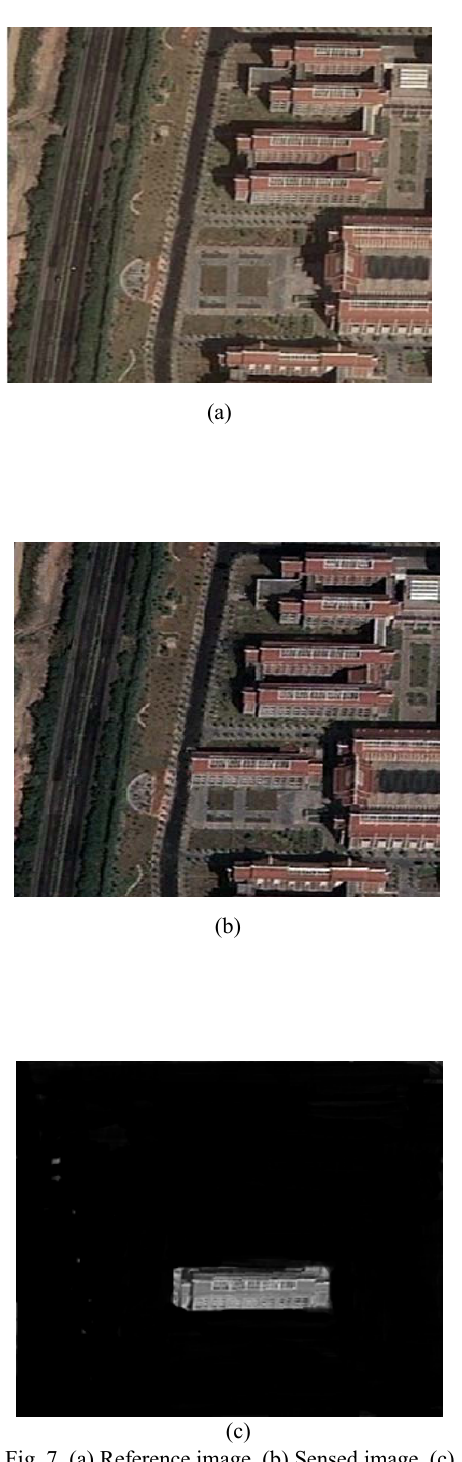
Fig. 7. (a) Reference image, (b) Sensed image, (c) Ground-truth map of the changed